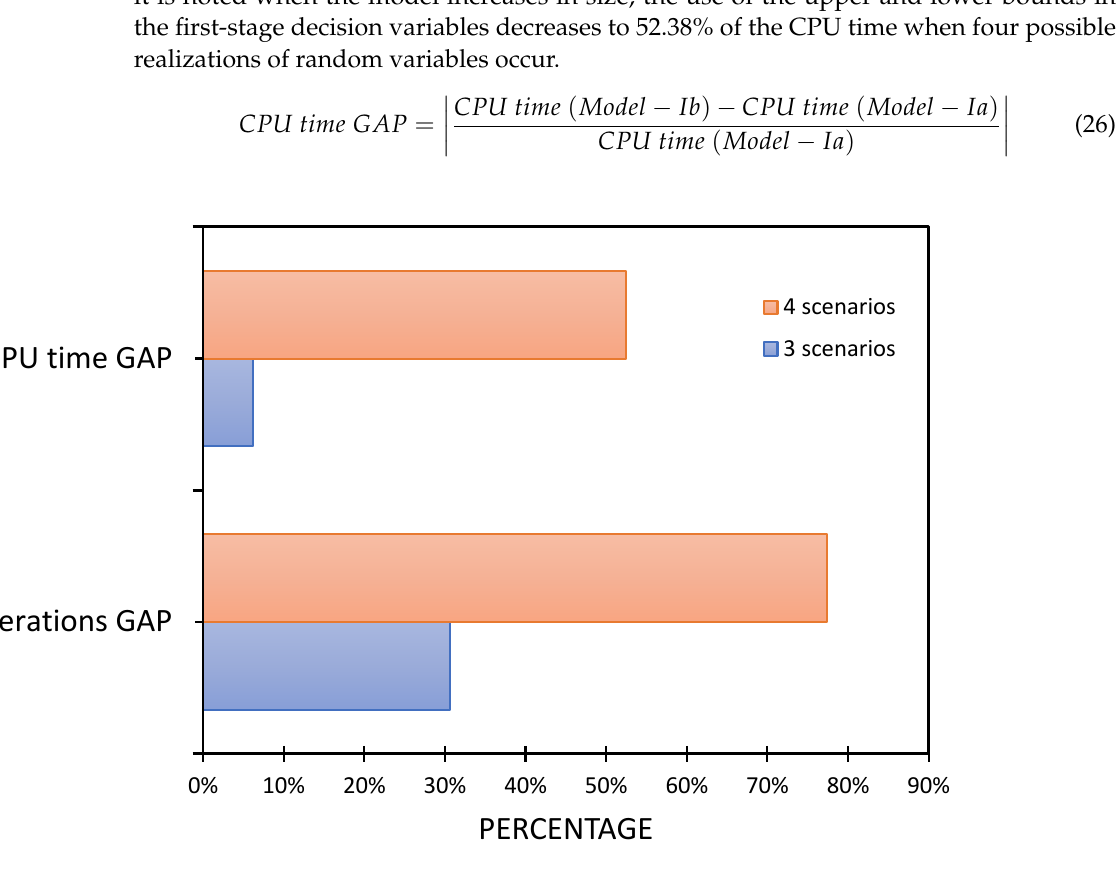
Figure 2. Percentage GAP in CPU time and iterations for the developed models.